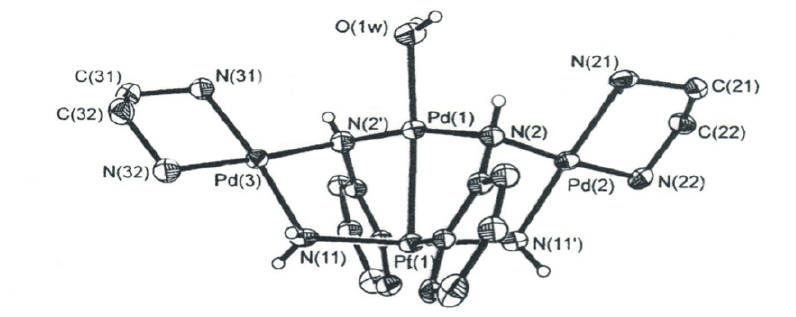
Figure 12. Structure of [Pt(µ-NH